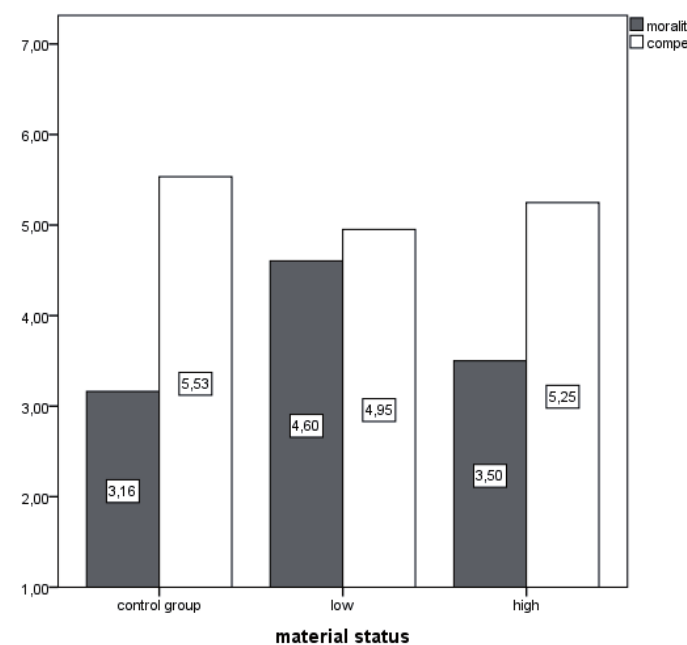
Figure 1. Mean scores for morality and competence assessments as a function of material status of a